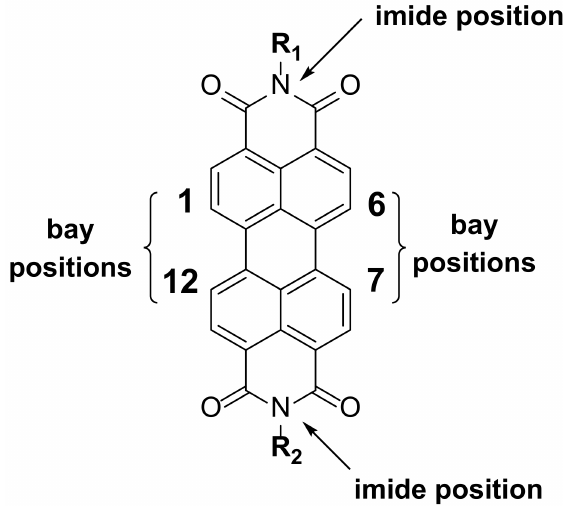
Figure 1. Structure of perylene diimide (PDI)